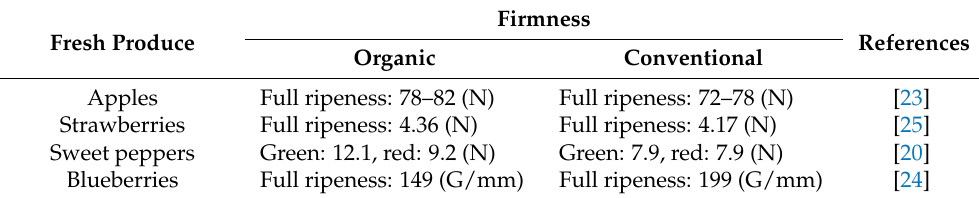
Table 1. The firmness content of organic and conventional fresh produce.